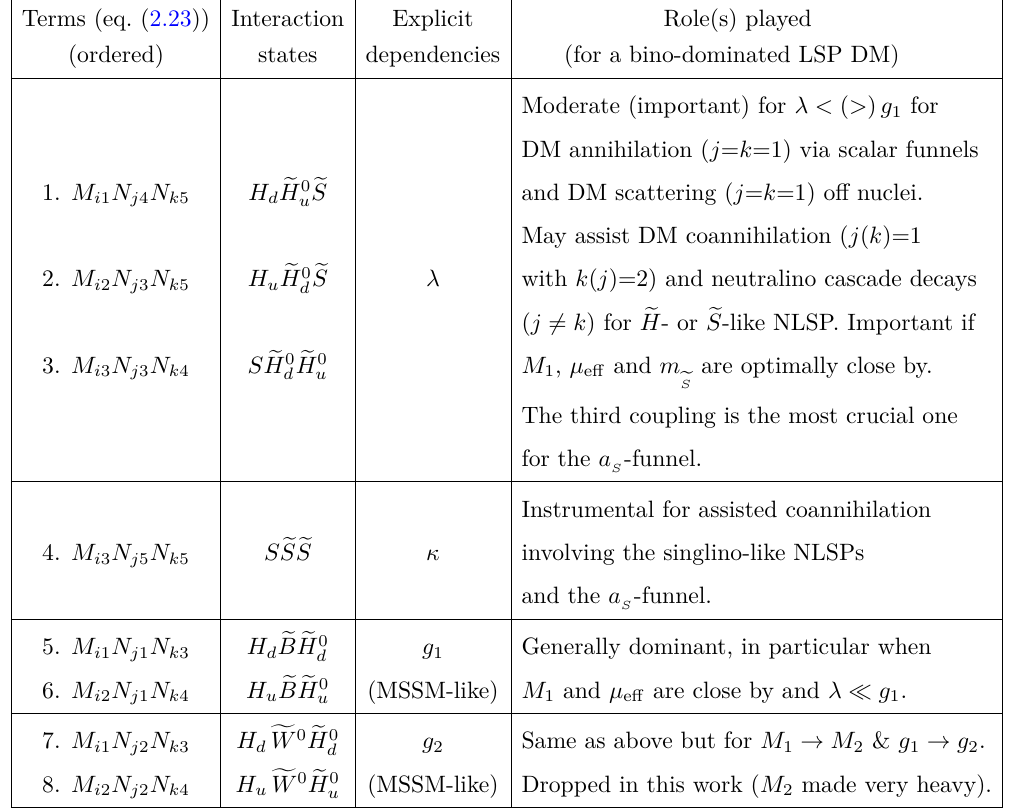
Table 2 . Components of the neutralino-neutralino-scalar (Higgs) coupling, g the participating interaction states present as admixtures in the neutralinos and the scalars, the model parameter on which each of those explicitly depend on and a brief description of salient roles the components play in reference to a bino-dominated